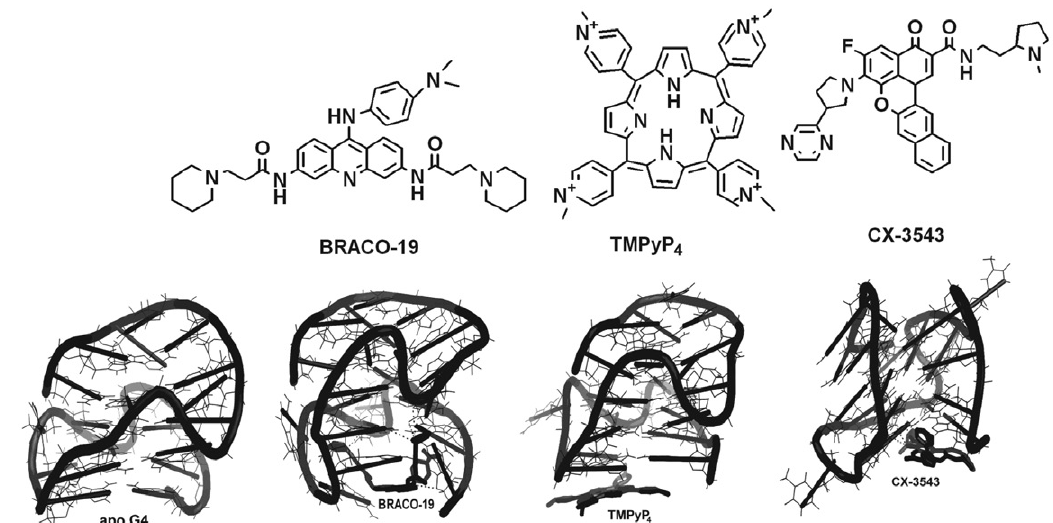
Figure 5. External stacking of BRACO-19, TMPyP 4 and CX-3543 to apo (ligand-free) G4 from the c-Myc promoter in the stable regime of molecu- lar dynamics (MD) simulation. In a representative set of structurally diversified ligands, these three molecules were established to have the highest affinity for G4. Only BRACO-19 was shown to be a thermodynamically favorable binder by increasing the conformational flexibility of G4 in the asymptotic ( t → ∞) regime of MD simulation. 68